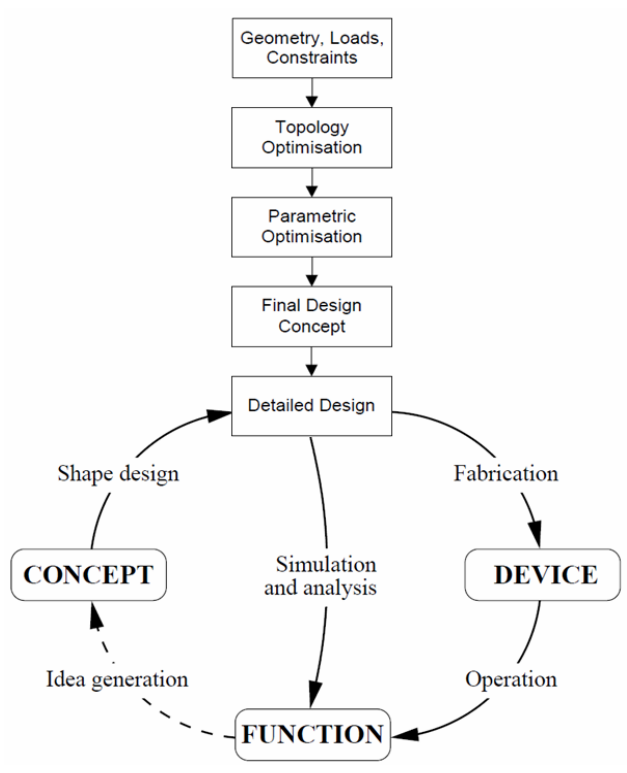
Figure 1. The product development iteration cycle